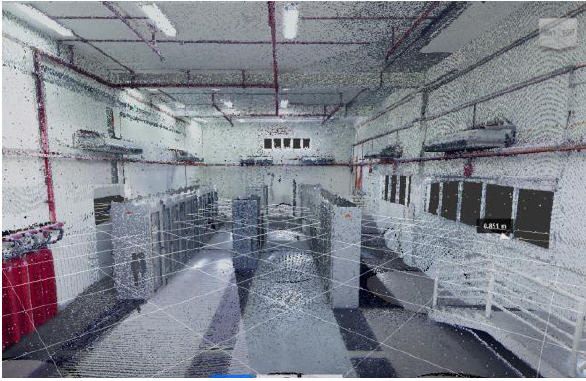
Figure 6: Cleaned registered point cloud in Autodesk Recap